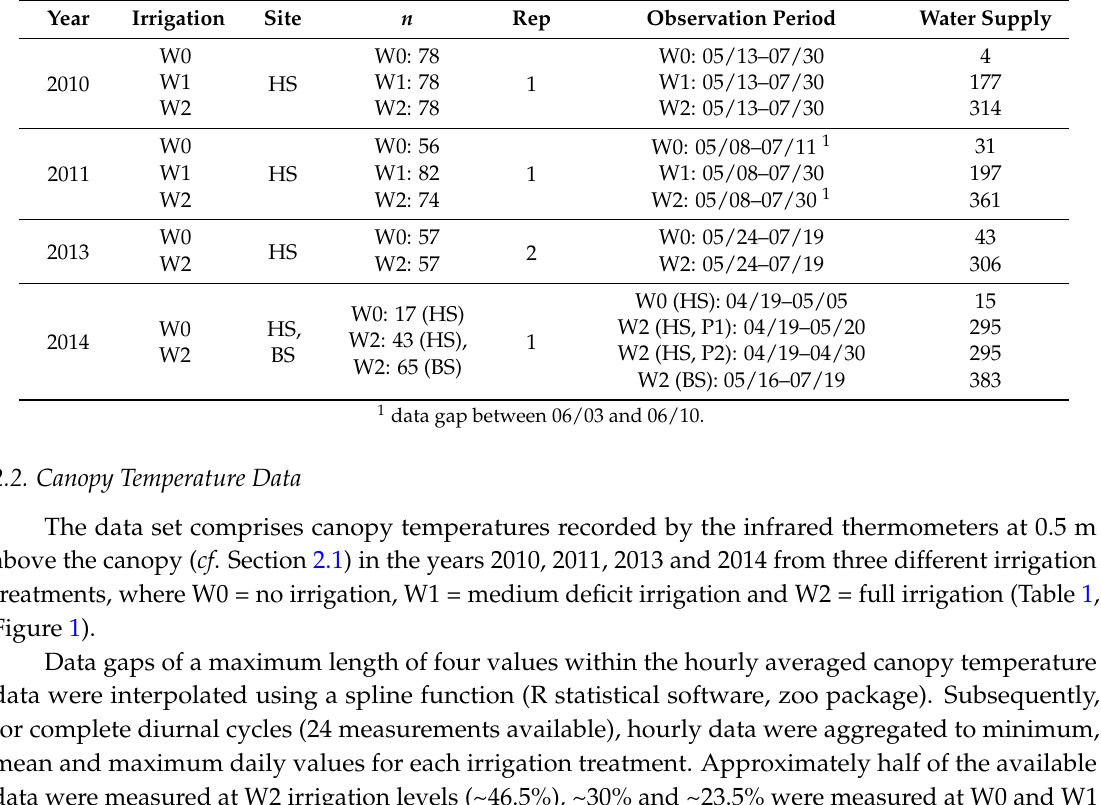
Table 1. Summary of the canopy temperature data set (HS = Hohenschulen research site, BS = Braunschweig research site, W0 = no irrigation, W1 = medium deficit irrigation and W2 = full irrigation, n = number of observations (24 h time step), Rep = number of measurement replications, HS P1 and HS P2 = plots at HS research site, Water supply = sum of irrigation water and precipitation from 03/01 to 07/30